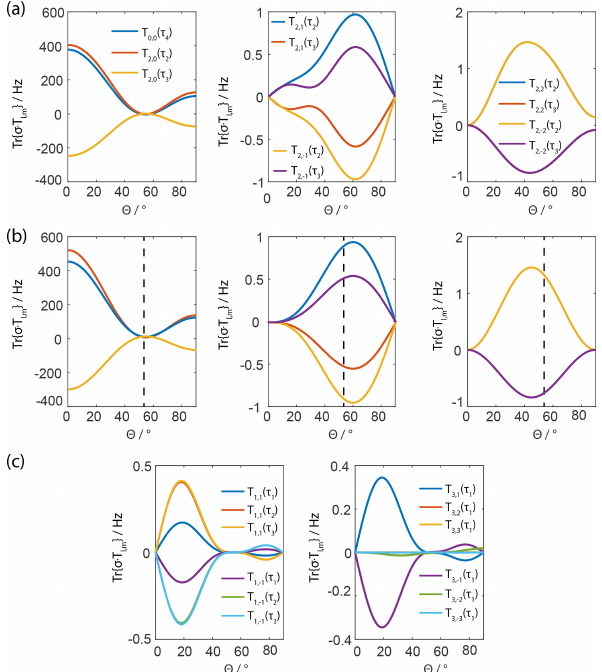
Figure 1. Projection of the magnitude of the three-spin tensor op- erators of the second-order effective Hamiltonian from analytical calculations (b) or numerical simulations (a, c) . Panels (a) and (b) show the same tensor components, which are comparable in magnitude. The effective Hamiltonian was calculated for a Lee– Goldburg-type irradiation scheme with a (2 π ) − (2 π ) rotation about the effective-field angle θ . For the calculations a Hamiltonian with two homonuclear dipolar couplings was assumed and the powder values were set to α = β = 45 ◦ and the relative orientation of the dipoles to (cid:56) = 45 ◦ with the dipolar couplings set to δ 1 , 2 = 10kHz and δ 1 , 3 = 20kHz. The ratio of the modulation frequency of the pulse sequence and the MAS frequency was assumed to be 10 in order to avoid higher-order contributions to the numerical simula- tions. It is obvious from the magnitude of the tensor components that only the T 0 , 0 ( τ 4 ) and the T 2 , 0 ( τ 2 ) and T 2 , 0 ( τ 3 ) terms are rele- vant but they exhibit a broad minimum centered around the magic angle, which is indicated by the black dashed line. For a definition of the three-spin spherical-tensor operators, see Garon et al.